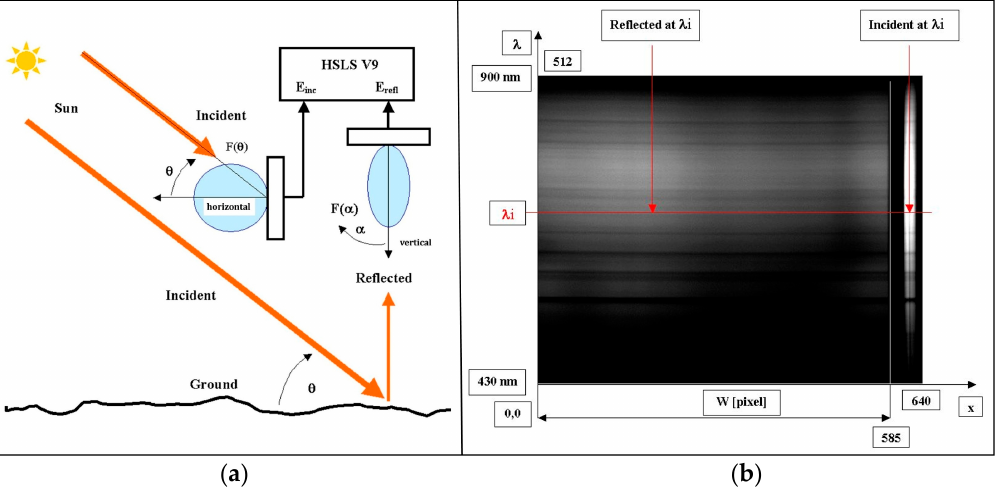
Figure 3. ( a ) Geometry in the vertical plane of measurement with the HSLS V9 (picture courtesy of M. Baji ć ). ( b ) Output images from the HSLS V9 and PixelFly digital area camera in a spectral range from 430 to 900 nm. Left: 585 × 512 (reflected) pixels show 8-bit intensity of reflected waves. Right: 55 × 512 (incident) pixels at the right side of the image contain information on incident waves in binning II configuration.